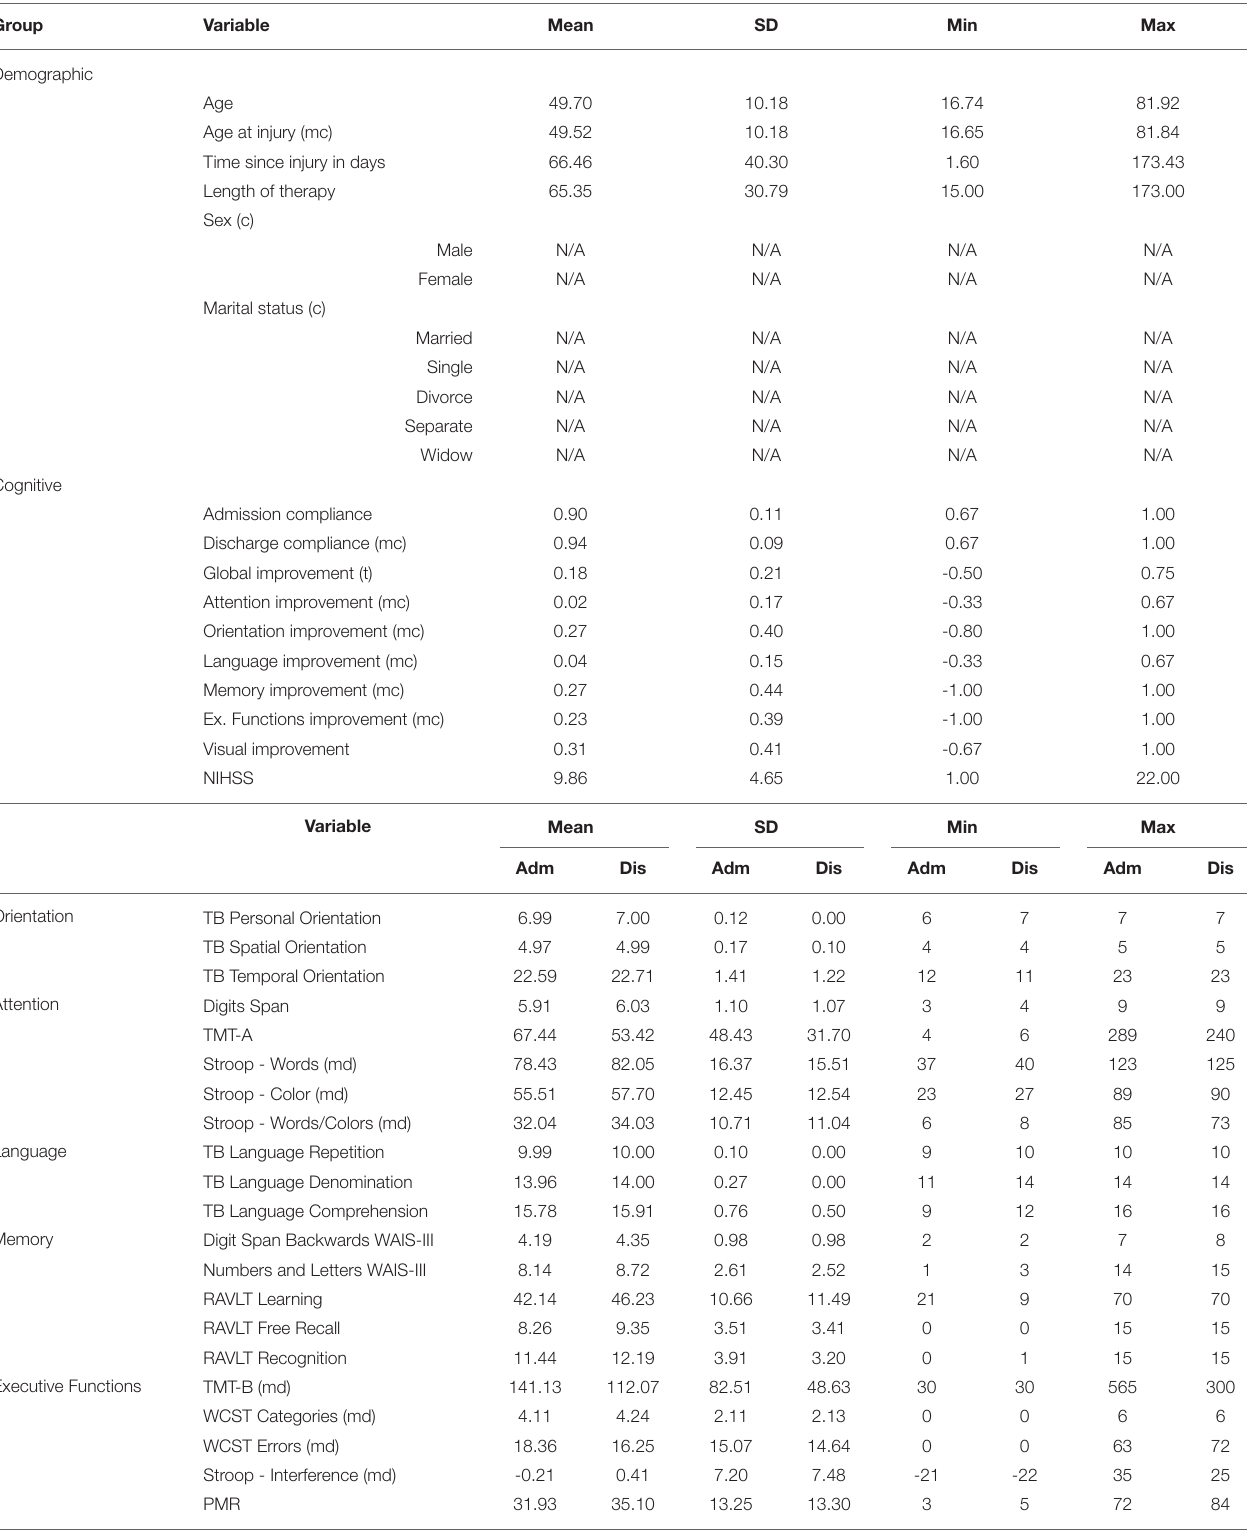
TABLE 3 | Basic statistics of demographic, cognitive and therapy variables from the rehabilitation dataset. Group Variable Mean SD Min